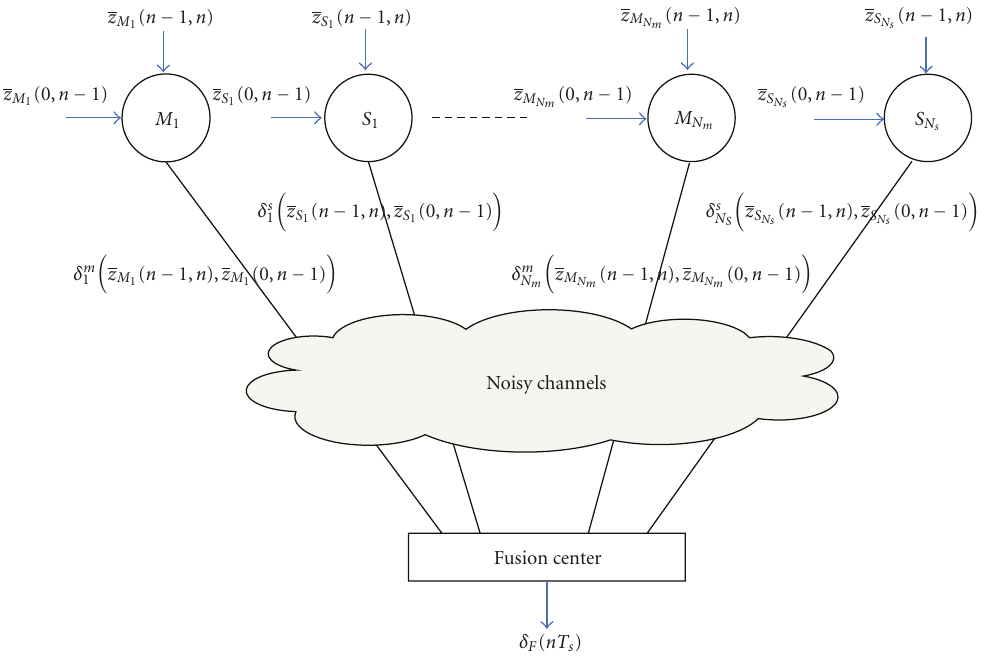
Figure 5: Decision Fusion Architecture for the Hybrid Sensor Network with Nodes Updating Decisions over